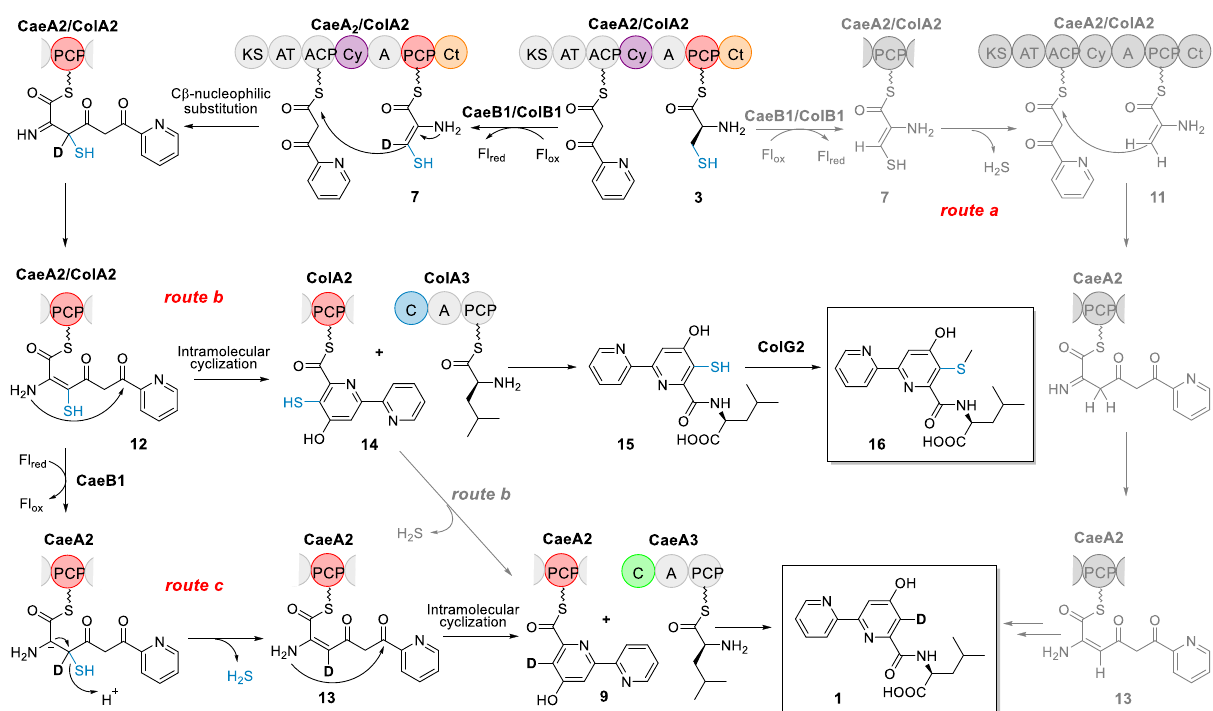
Fig. 5 Proposed mechanisms for 2,2 ’ -bipyridine formation. The PCP domain of CaeA2 is labeled in red. The C domains of CaeA3 and ColA3 are highlighted in green and blue, respectively. In contrast to favored routes b and c , unfavored route a is shown by gray color. Fl ox oxidized fl avin, Fl red two- electron reduced fl